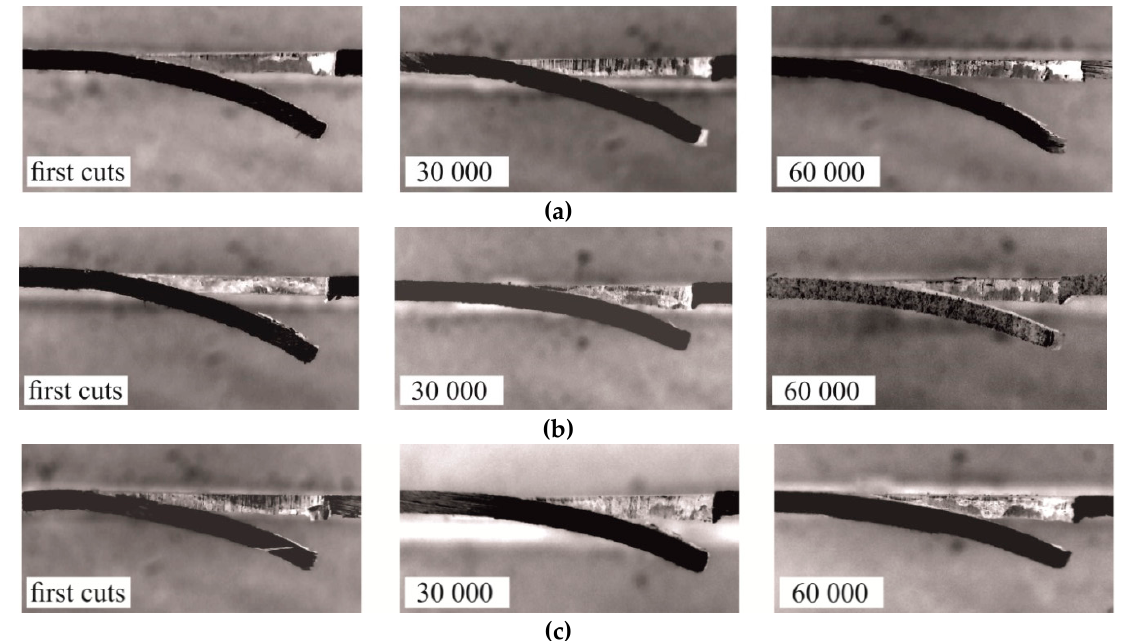
Figure 11. Cross-section of the hook for a particular number of punch cuts: ( a ) C = 5%; ( b ) C = 10%; and ( c ) C = 15%. Table 4. Size R b and H b depending on the clearance and the number of cuts made by the punch.